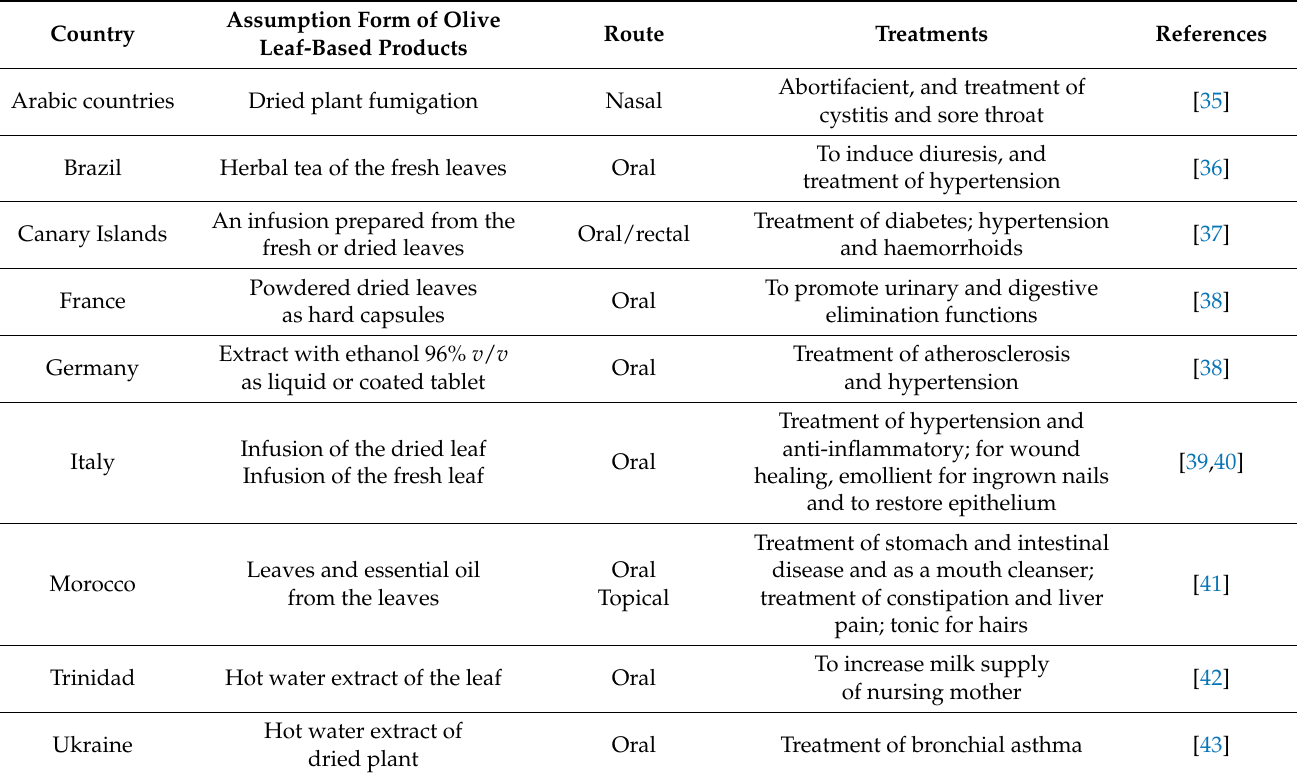
Table 1. Main uses of olive leaves in traditional medicine occurring